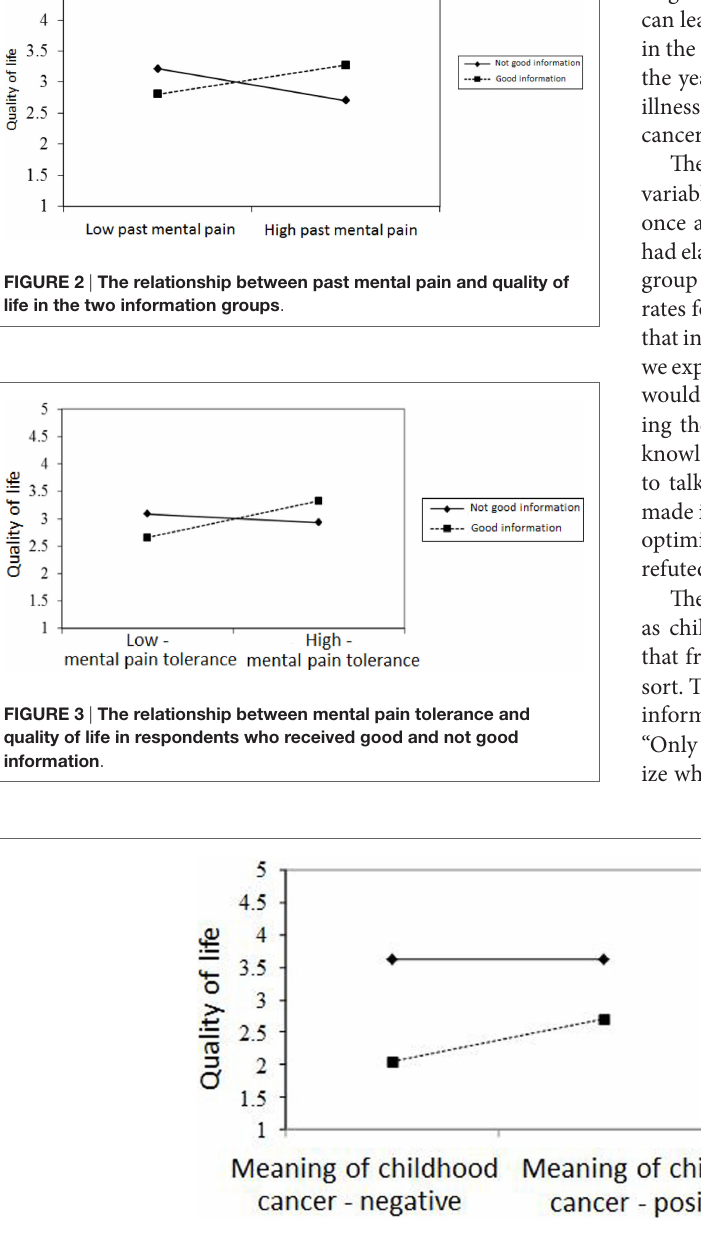
FigUre 4 | The relationship between meaning of cancer in childhood and quality of life in respondents with high/low present mental pain .